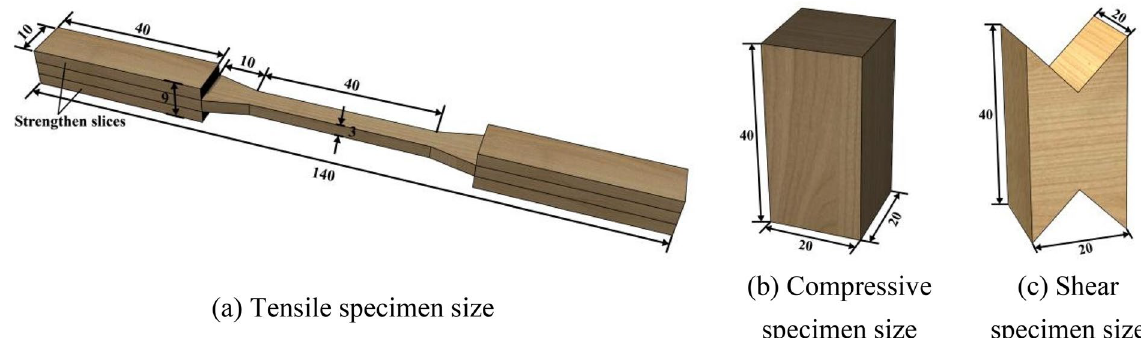
Fig. 5 Test specimens’ size of material properties (unit: